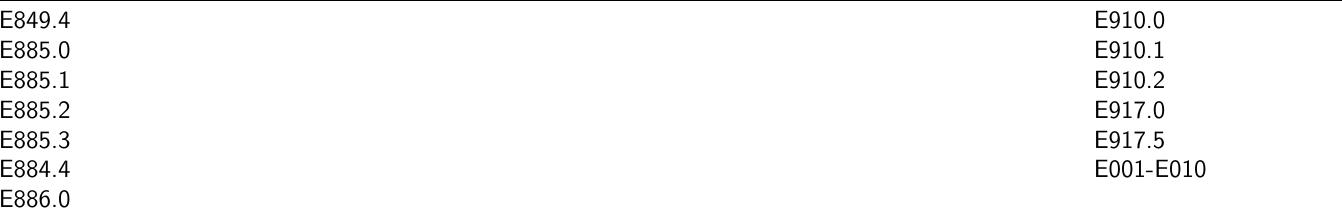
Table 3: ICD-9-CM codes used to identify sports & recreational injuries